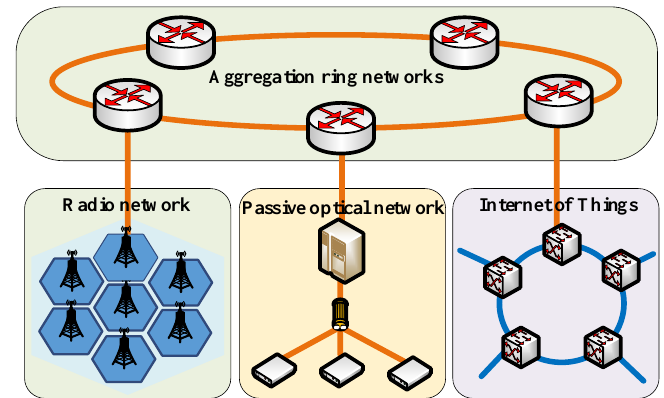
Figure 1. Optical access network with aggregation ring.